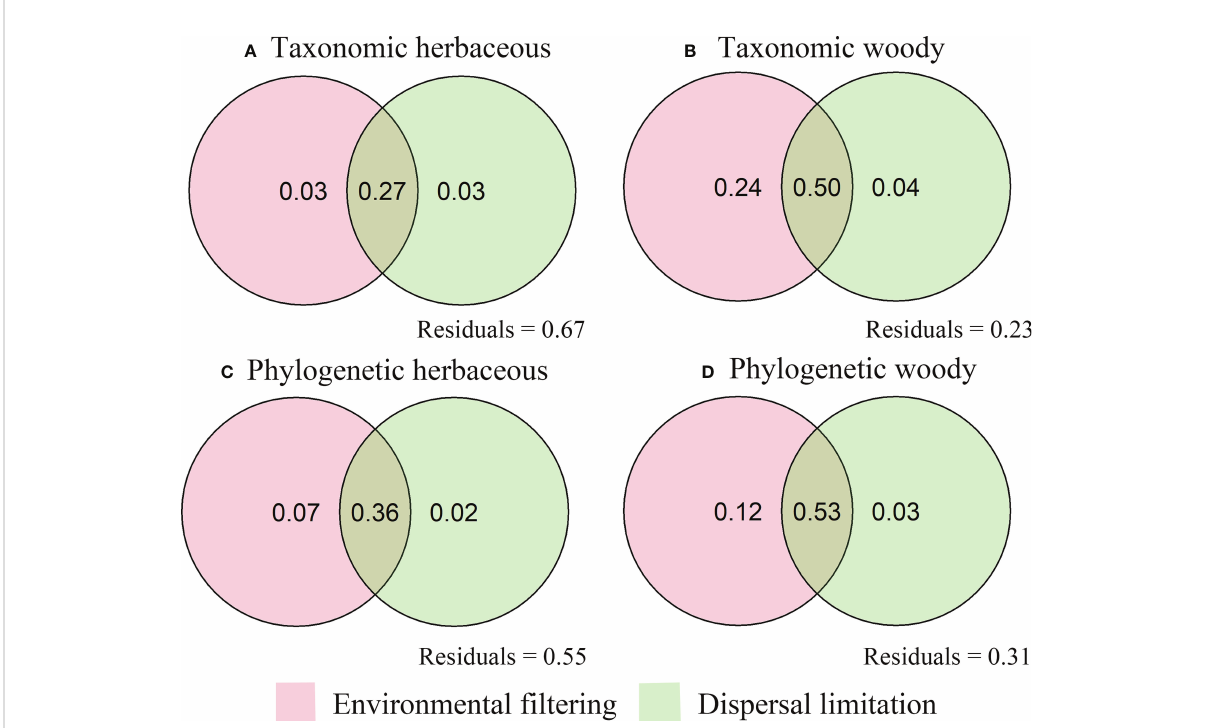
FIGURE 6 Venn diagram displaying the relative importance of environmental fi ltering and dispersal fi ltering on herbaceous (A, C) and woody (B, D) species turnover in the arid and semiarid areas of